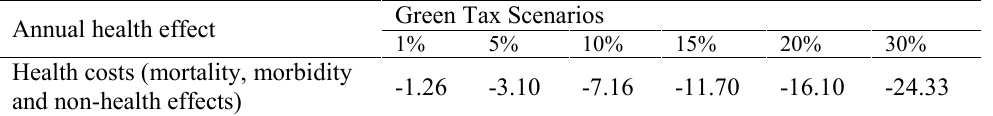
Table 3. Estimating the impact of annual health costs caused by the application of different green tax